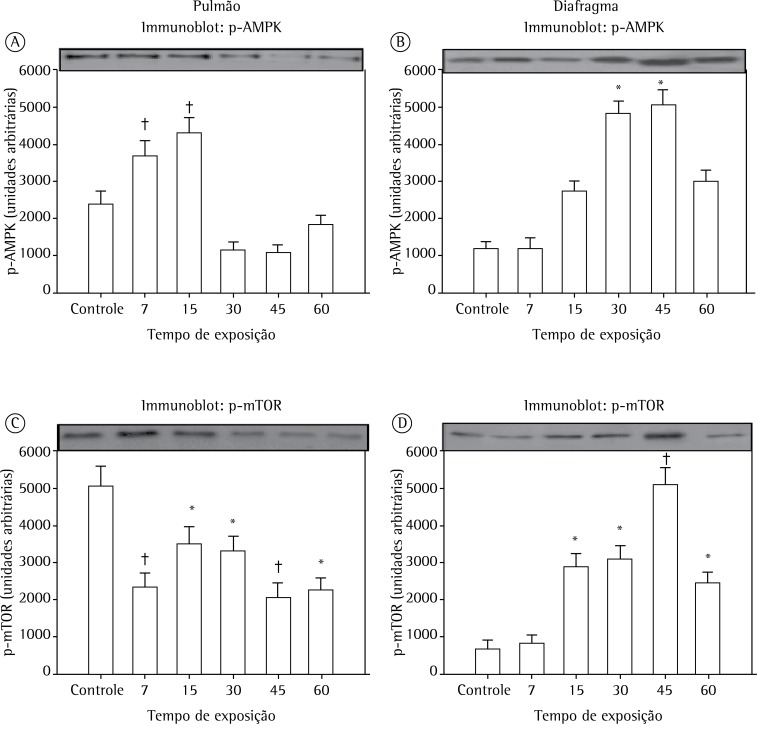
Em A e B, média ± EPM para expressão de phosphorylated AMP-activated
protein kinase (p-AMPK) no tecido pulmonar e no músculo diafragma,
respectivamente. Em C e D, média ± EPM para expressão de phosphorylated
mammalian target of rapamycin (p-mTOR) no tecido pulmonar e no músculo
diafragma, respectivamente. Os dados são referentes a 6 grupos de
camundongos: grupo controle e 5 grupos expostos a fumaça de cigarro por 7,
15, 30, 45 e 60 dias, respectivamente. *p < 0,01 vs. controle. †p <
0,001 vs. controle.